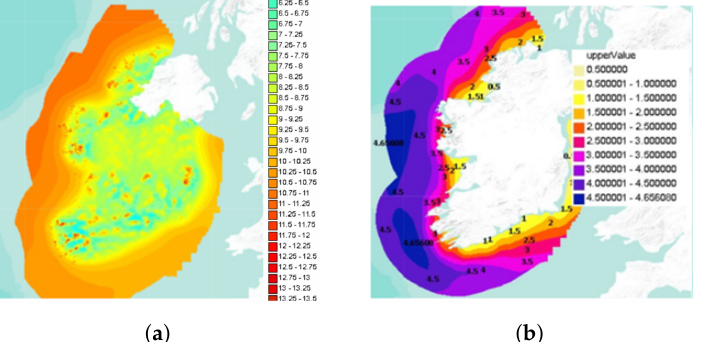
Figure 5. ( a ) Mean wind speed at 125 m (2013) [49], ( b ) Mean Annual Practicable Power Resource Pelamis MWhe/km [50].